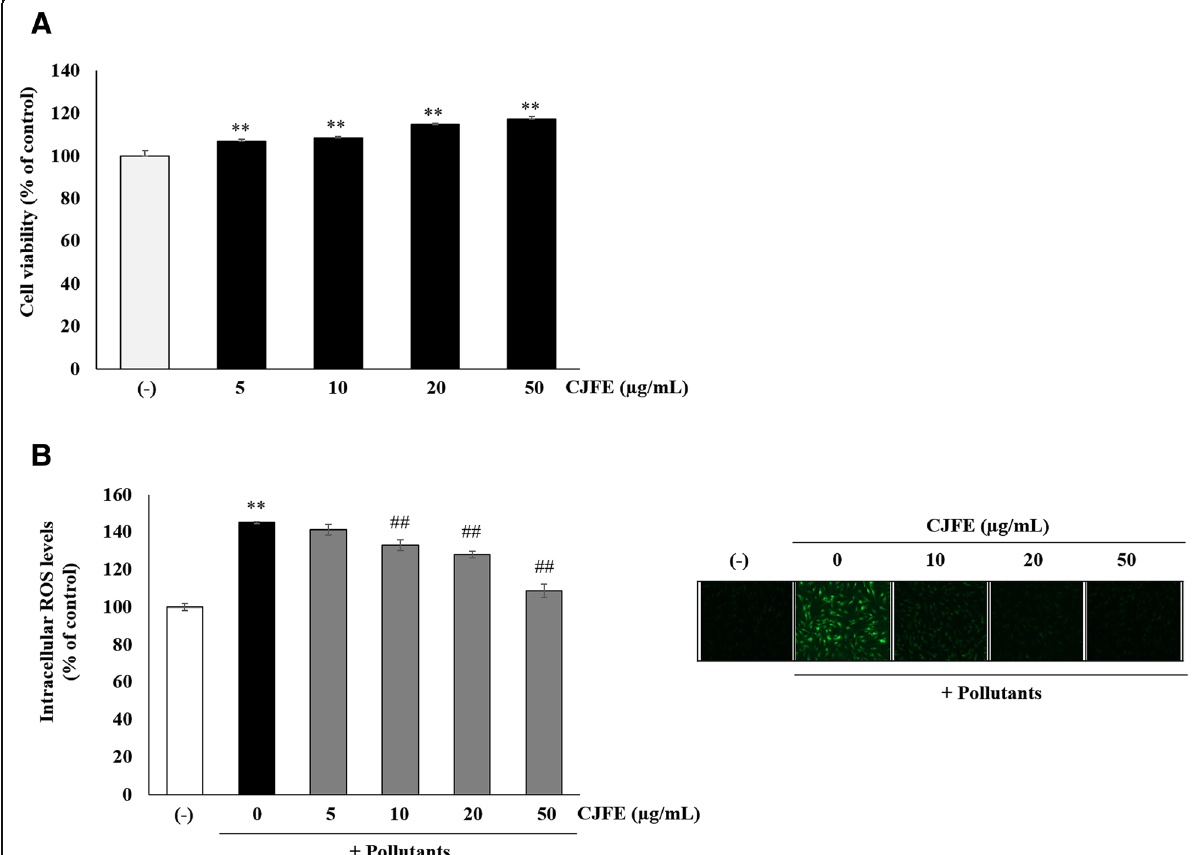
Fig. 1 Cell viability ( a ) and intracellular ROS levels ( b ) in normal human dermal fibroblasts (NHDFs). Cell toxicity test in NHDFs was assayed by MTT assay. Intracellular ROS levels were determined by measuring the oxidative conversion of DFH-DA to the DCF. Fibroblasts were harvested and incubated with 50 μ M DCFH-DA at 37°C for 30min in the dark. The fluorescence intensity was monitored by an Infinite® F200 PRO. The results are mean±standard deviation (SD) ( n =3). * P <0.05, ** P <0.01 vs. pollutant-untreated control. # P <0.05, ## P <0.01 vs. pollutant-treated